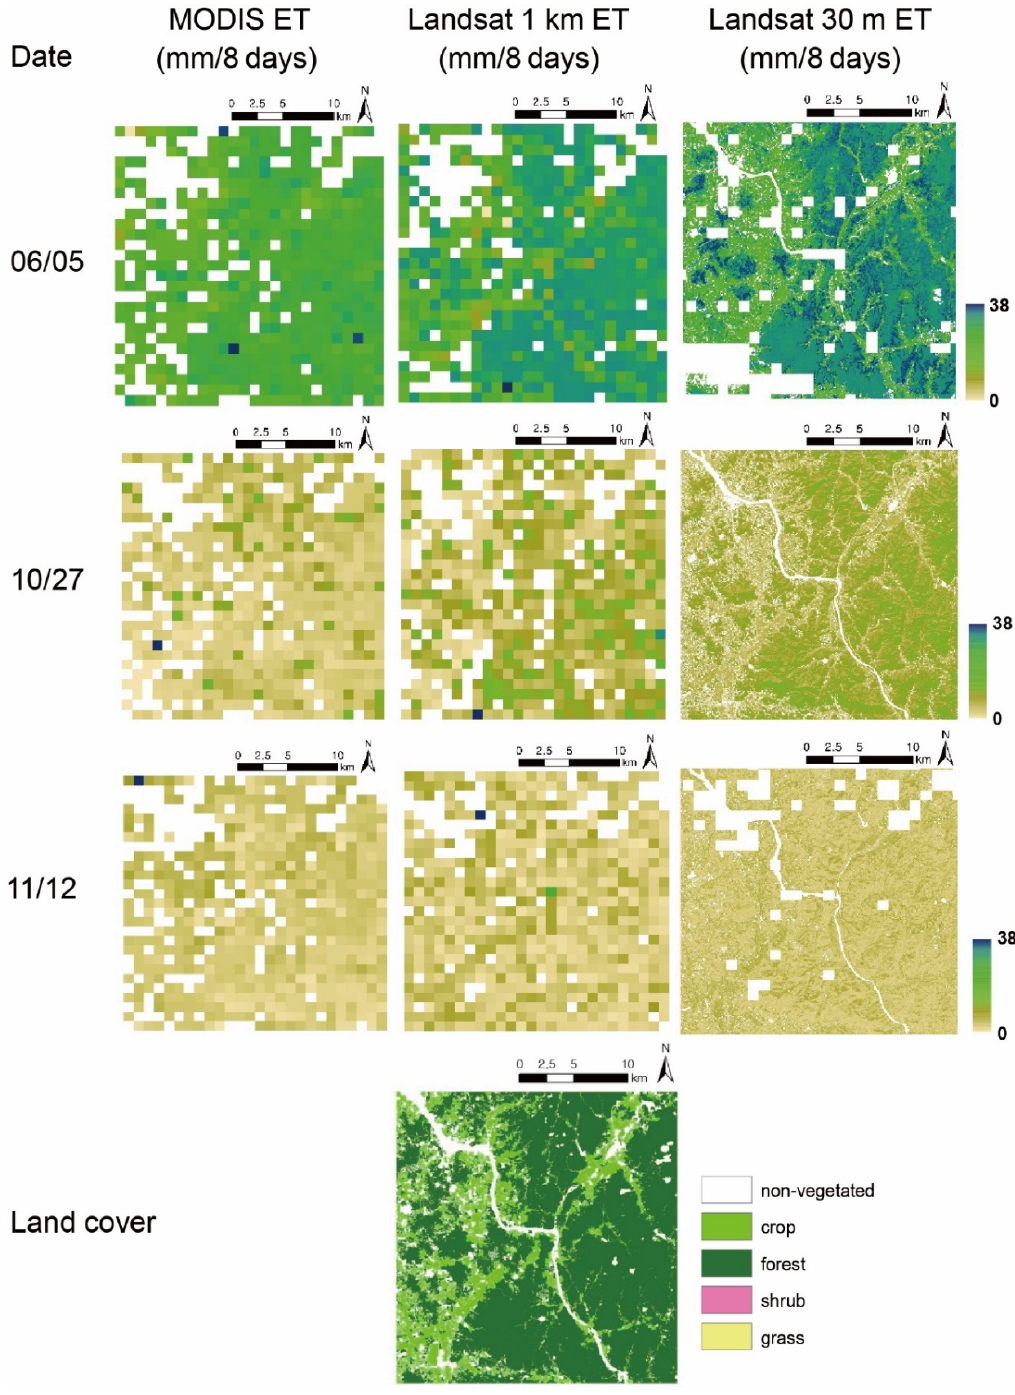
Figure 8. MODIS 8-day ET, Landsat 1 km ET and downscaled Landsat 30 m ET in the southwest part of Site 3 (refer to Figure 2f blue outline for the area boundary) during the year of 2013.